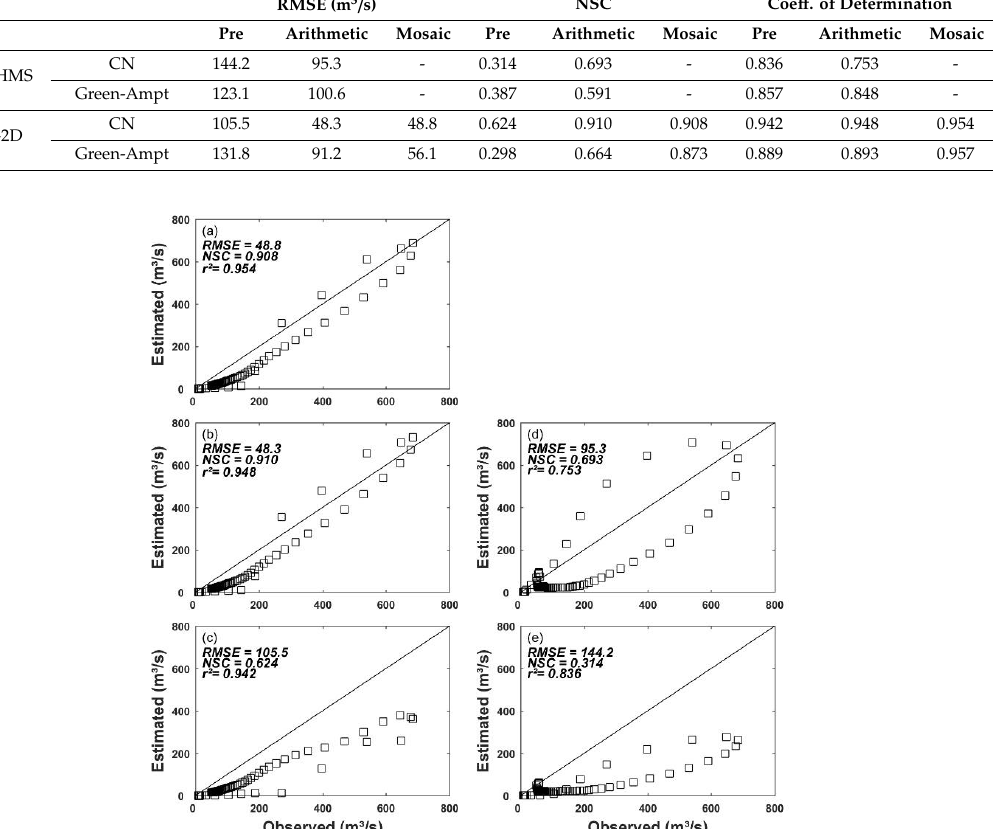
Table 2. Basic statistics for each method simulated by both FLO-2D and HEC-HMS at Cheongmi station. RMSE (m 3 / s)